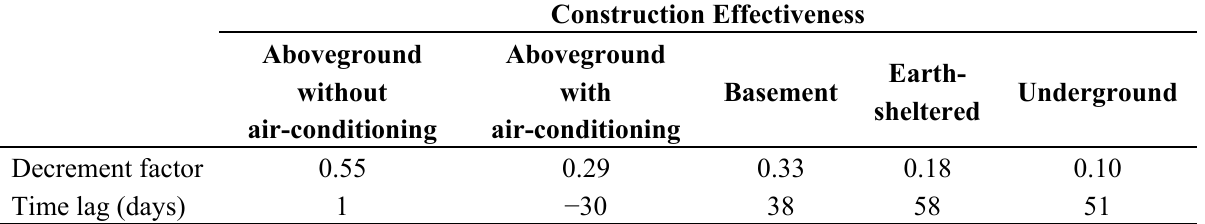
Table 2. Parameters that quantify the effectiveness of the construction to decrease annual outdoors